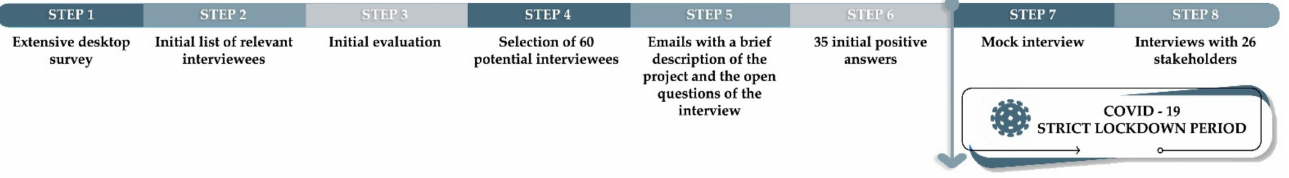
Figure 2. Survey design.